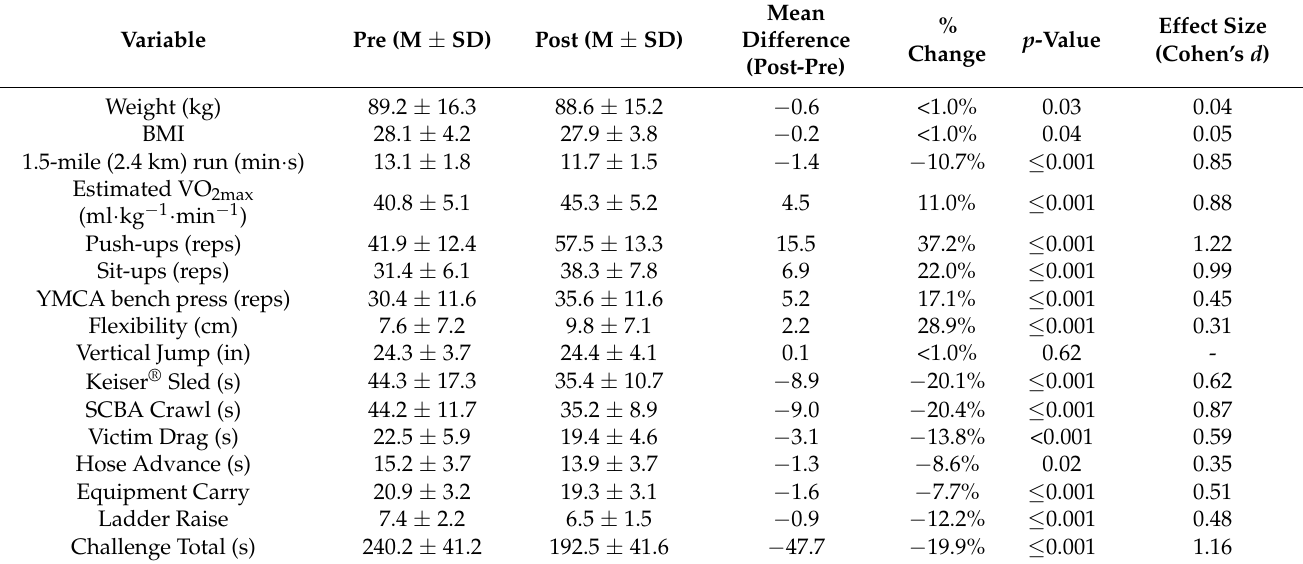
Table 4. Changes in Fitness and Firefighting Ability from Week-1 to Week-7.